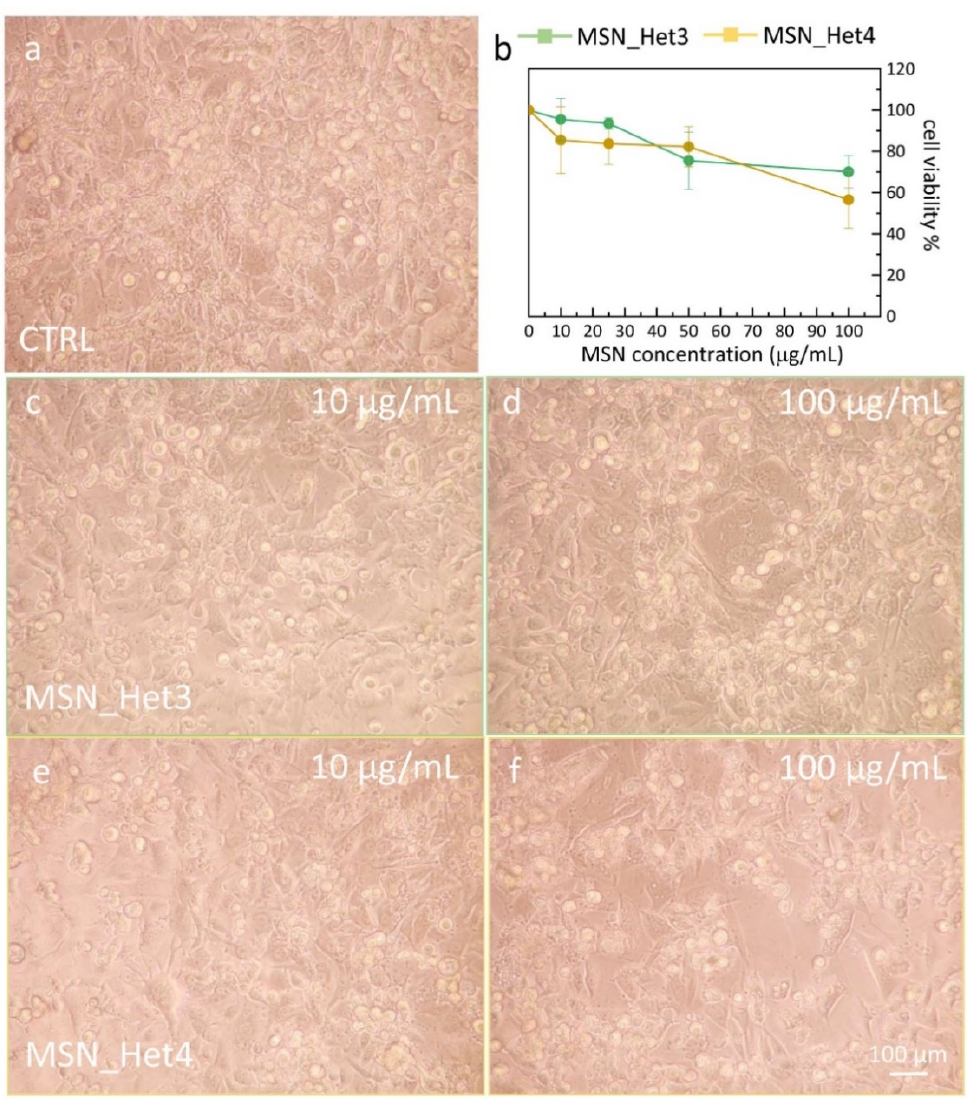
Figure 7. ( a , c – f ) Representative phase contrast optical images showing the morphology of bEnd.3 (20 × magnification) and of the control (CTRL, 100%) after 24 h treatment with MSN samples as labeled, prepared by the two-phase approaches, at the indicated concentrations. ( b ) Graph of the cell viability, determined by the MTT test, expressed as percentage of surviving cells in comparison with control (CTRL, 100%) represented by untreated bEnd.3 cells in serum-free DMEM.